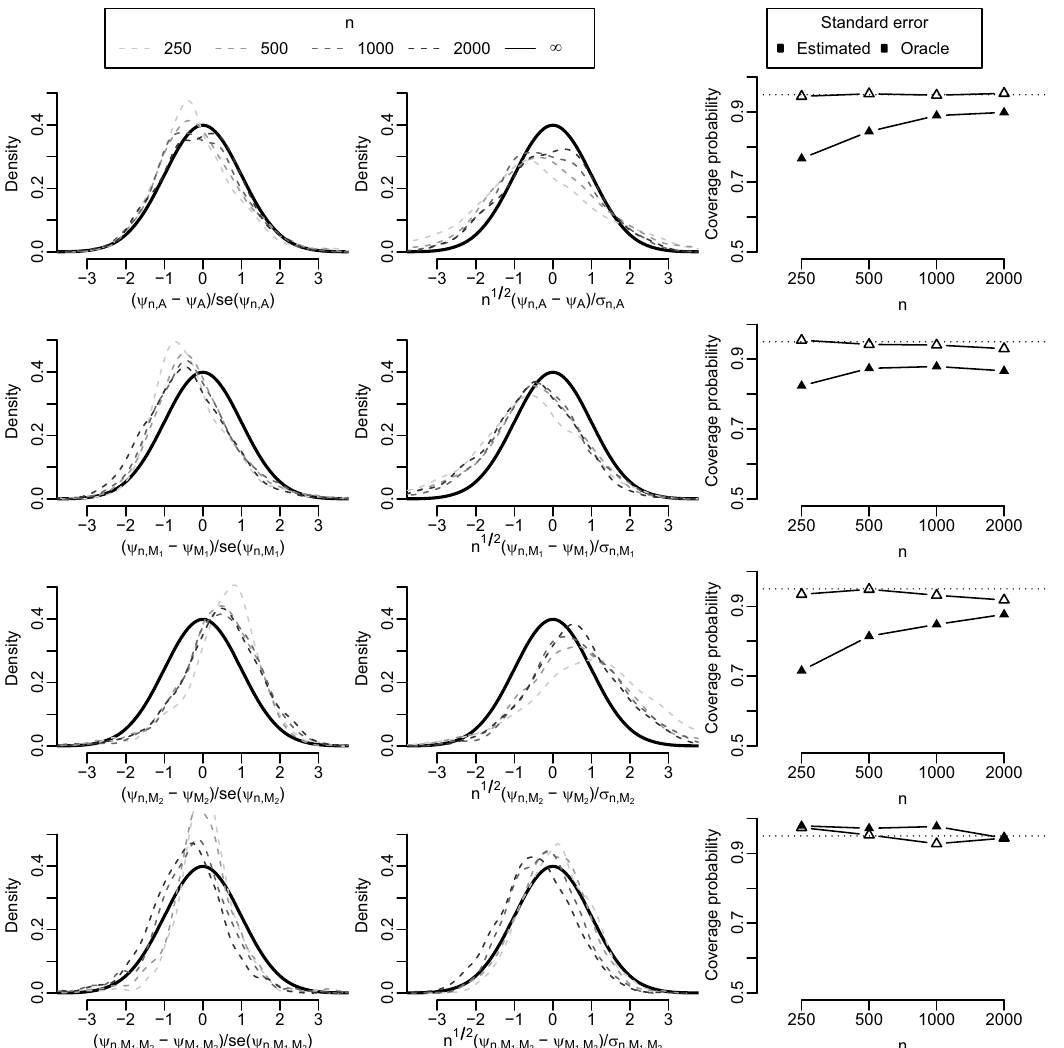
Figure 5: Illustration of weak convergence and Wald - style con fi dence intervals based on the one - step estimator that discretized mediator distributions into fi ve bins. The left two columns show the kernel density estimate of the sampling distribution of the centered estimates of interventional e ff ects scaled by the oracle standard error ( left ) and by their estimated standard error ( middle ) . In each case, the asymptotic distribution is shown in black. The right panel shows coverage probability of a nominal 95% Wald - style con fi dence interval based on an oracle standard error ( solid triangle ) and an estimated standard error ( open triangle )